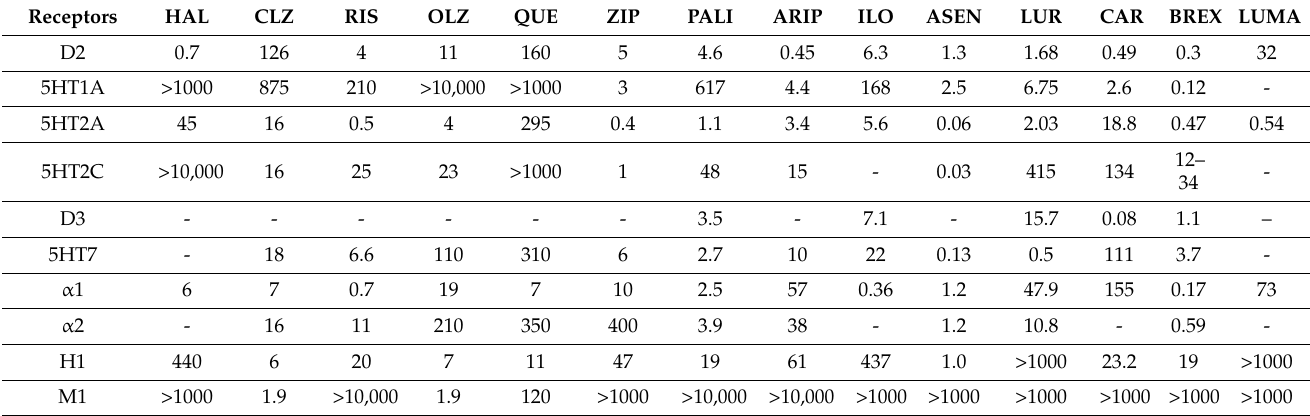
Table 1. Molecular targets and binding affinities (Ki, nM) for antipsychotic